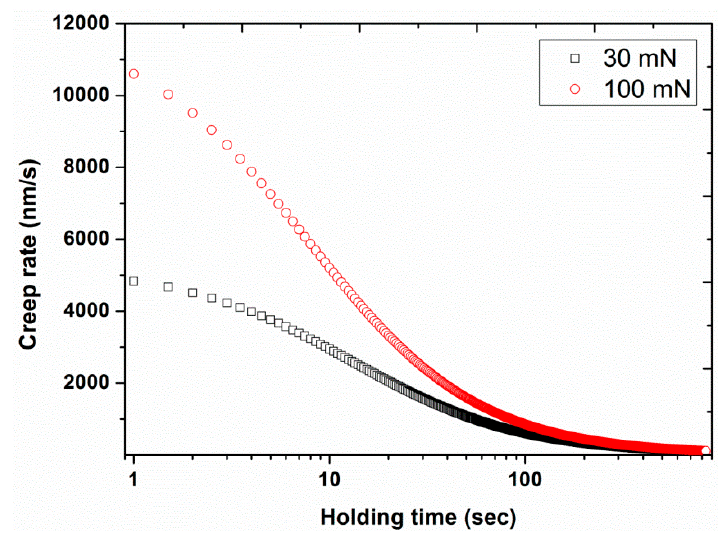
Figure 18. Creep rate as a function of holding time for the two peak loads, 30 and 100 mN.